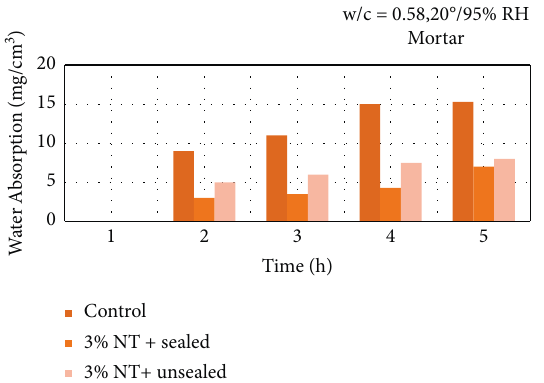
Figure 5: Time vs. water absorption of trail data with 50 ° C.